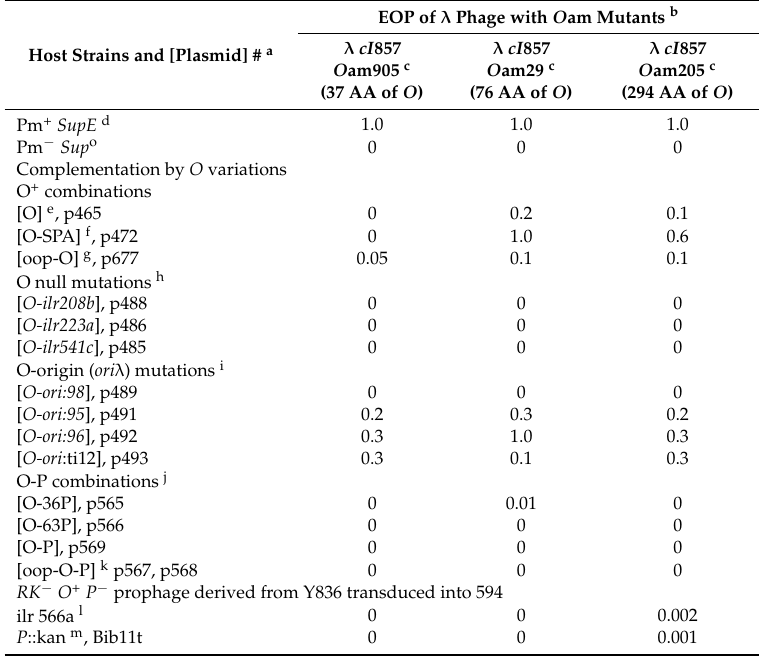
Table 2. Complementation of λ O am mutants by alleleic forms of O expressed from plasmids. EOP of λ Phage with O am Mutants Host Strains and [Plasmid] # a